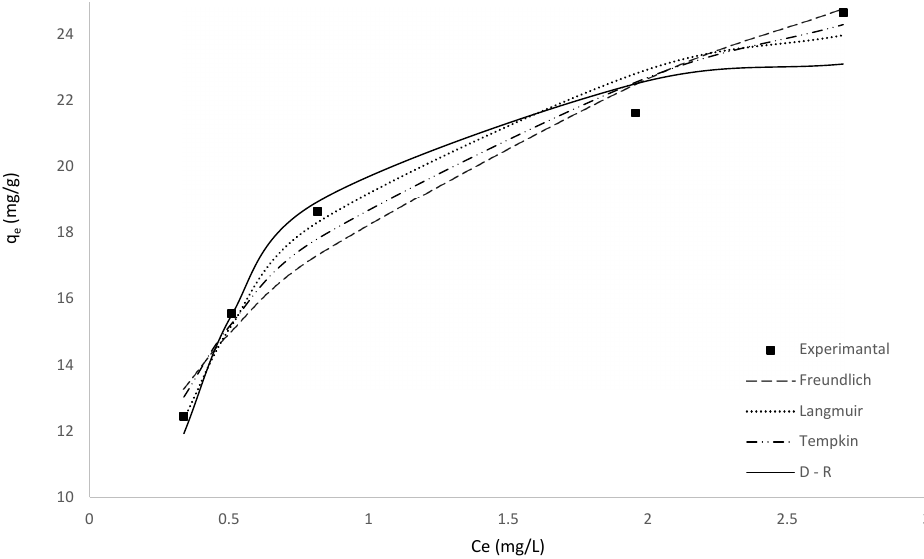
Figure 6. Comparison of the experimental and modelled isotherms for the adsorption of MV by HNC.